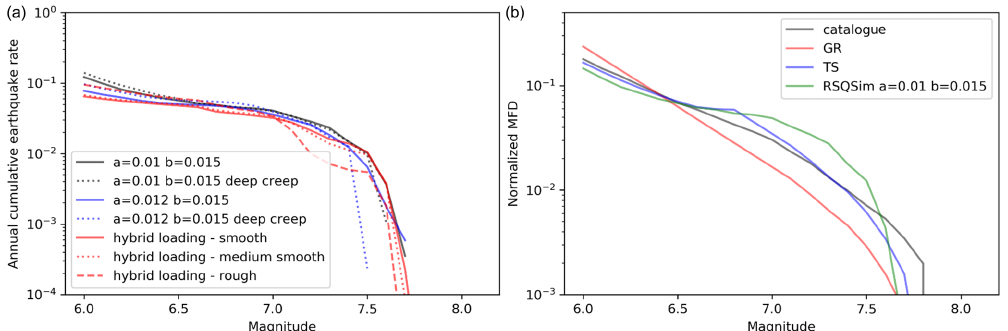
Figure 10. (a) MFD of the synthetic catalogues generated from the RSQSim simulations exploring a range of input parameters. (b) Nor- malized MFD of the earthquake catalogue, the MFD of the faults modelled using SHERIFS with a GR MFD or a TS MFD (the background seismicity has been removed), and the RSQSim synthetic catalogue ( a = 0 . 01 b = 0 .